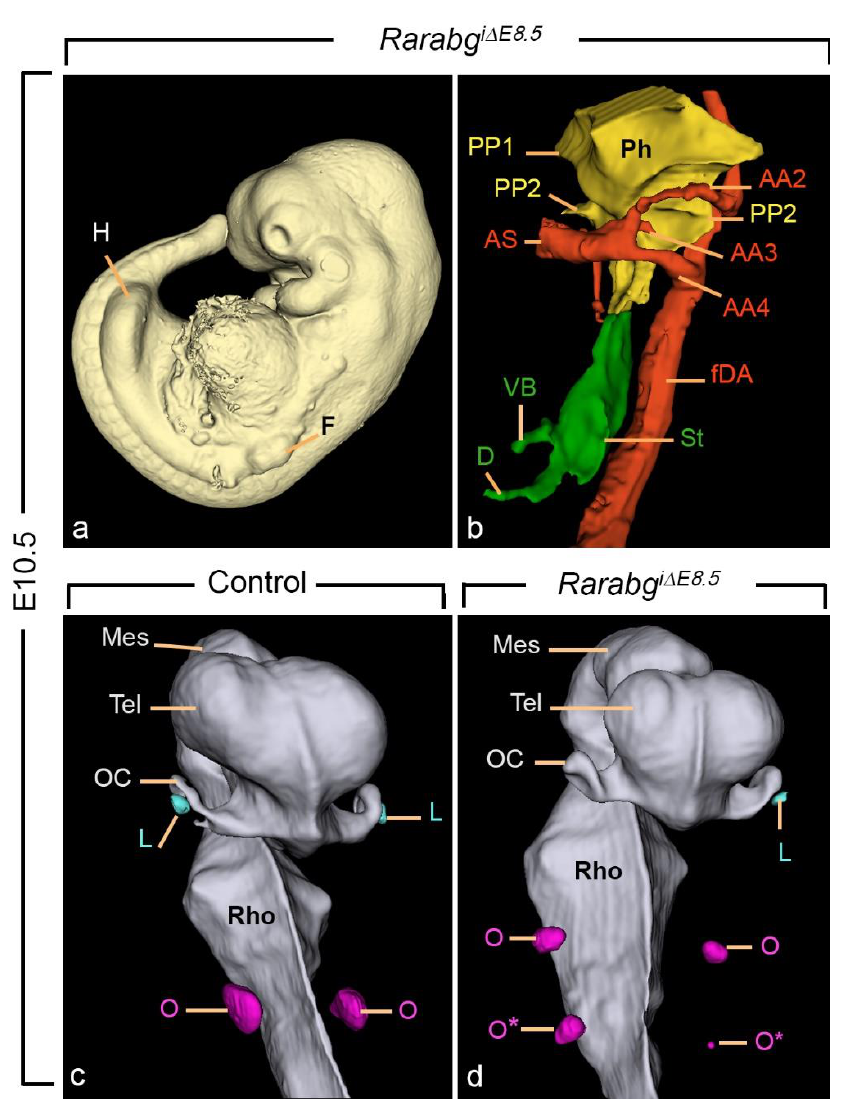
Figure 11. Anatomical features characteristic of the Rarabg i ∆ E8.5 mutant phenotype at E10.5. ( a ) Left lateral view of the external aspect. Note the small size of the forelimb bud (F), as opposed to the normal appearance of the hindlimb bud (H) and compare with Figure 2a. ( b ) Left lateral view of a 3D-reconstruction of the pharyngeal and foregut regions. Compare with Figure 3a and note: (i) the abnormal persistence of the 2nd aortic arch (AA2) and (ii) the absence of the dorsal portion of the 3rd aortic arch (AA3), of the 6th aortic arch, of the 3rd and 4th pharyngeal pouches, and of the dorsal pancreatic bud. ( c , d ) Ventral views of 3D-reconstructions of the brain region of a control embryo ( c ) and of a Rarabg i ∆ E8.5 mutant ( d ) at E10.5. Note the marked hypoplasia of the mutant otocysts (O), the presence of ectopic otocysts (O*), and the absence of the lens (L) on the right side. AA2, AA3, and AA4, 2nd, 3rd, and 4th aortic arches; AS, aortic sac; fDA, left dorsal aorta; D, duodenum; Mes, cavity of the mesencephalon; OC, optic cup; Ph, pharyngeal cavity; PP1 and PP2, 1st and 2nd pharyngeal pouches; Rho, cavity of the rhombencephalon; St, stomach; VB, ventral bud of the foregut; Tel, telencephalic vesicle. Same magnifications in ( c , d